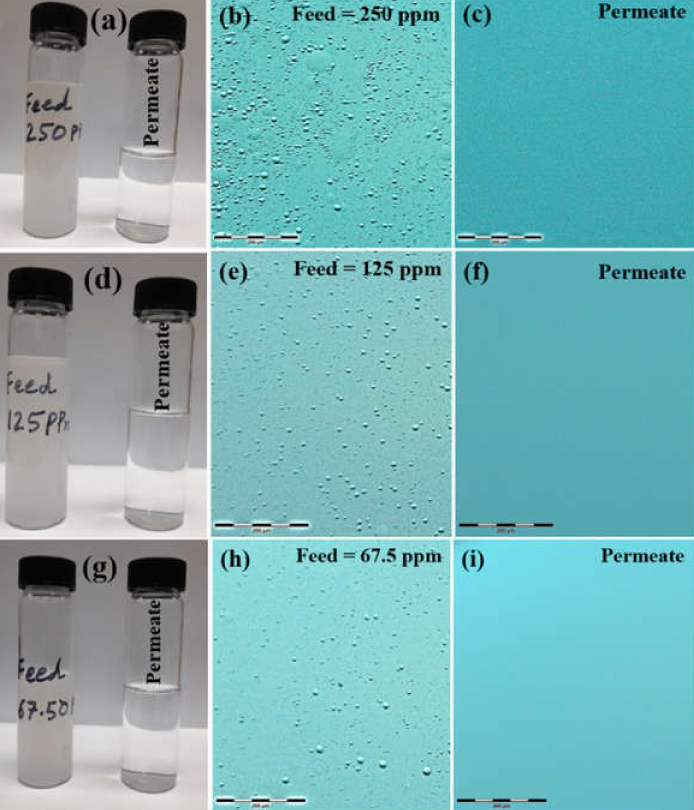
Figure 11. Photographs of ( a , d , g ) experimental samples of feed and permeate, optical images of ( b , e , h ) feeds and ( c , f , i ) permeates collected at 1 bar using M-100